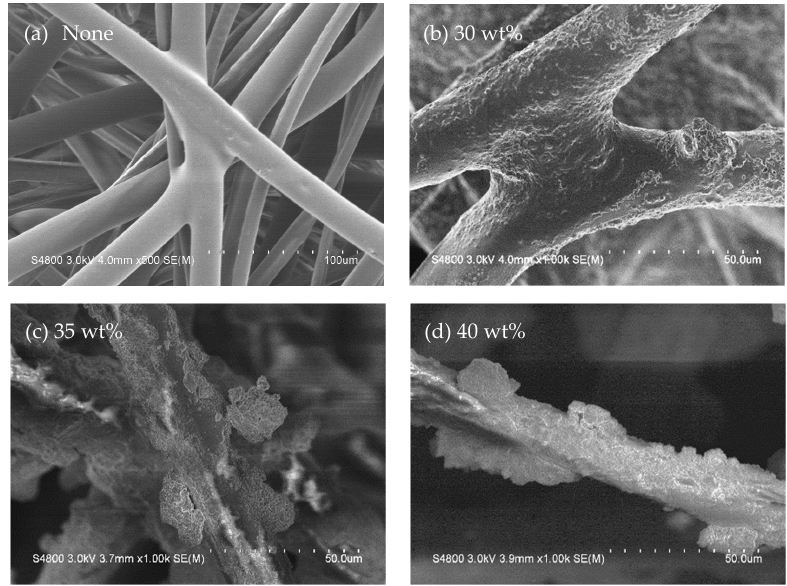
Figure 5. SEM images of ( a ) control group; and STF-saturated composite nonwoven fabrics as related to the STF concentration, being: ( b ) 30 wt%.; ( c ) 35 wt%.; ( d ) 40 wt%.